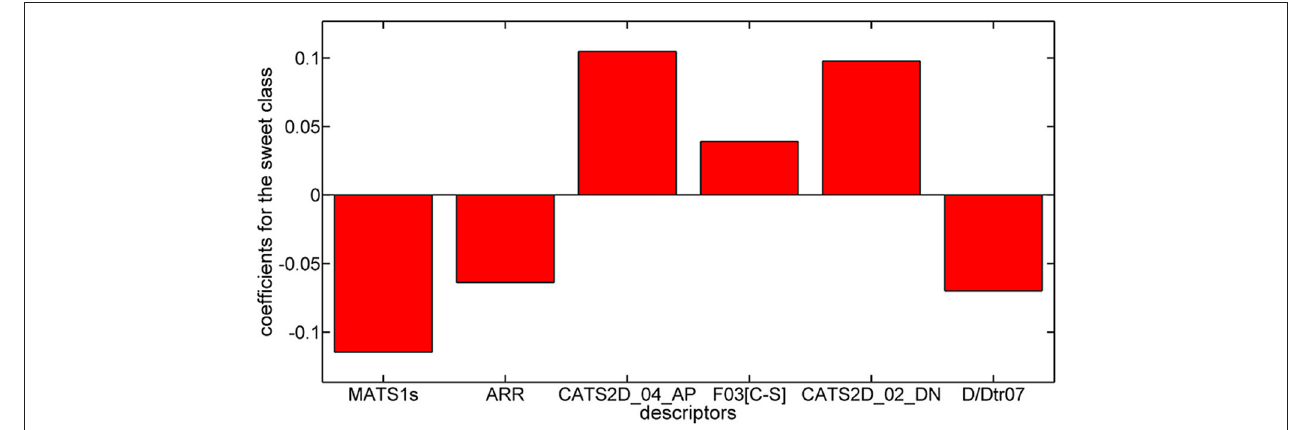
FIGURE 3 | Coefficients for training descriptors in the PLSDA model for the sweet class.